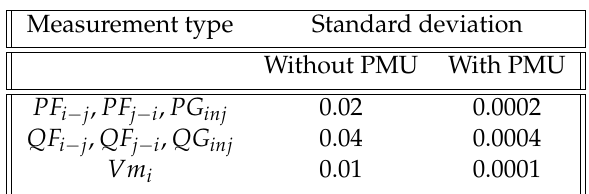
Table 3. Measurements standard